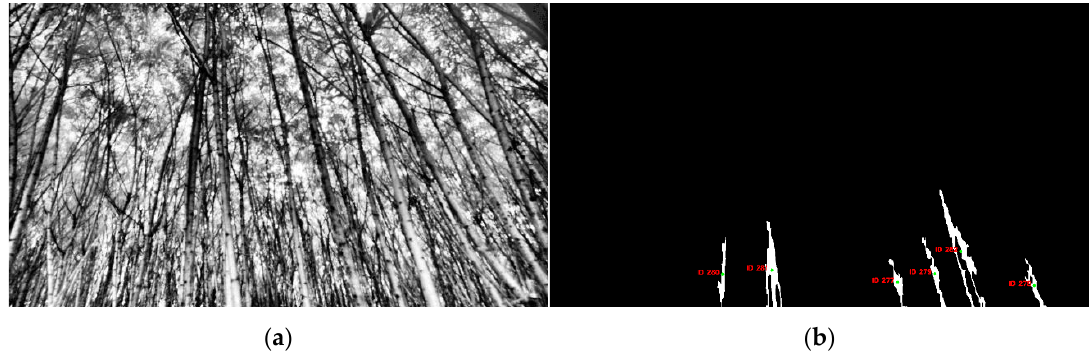
Figure 11. ( a ) CLAHE equalized frame; ( b ) segmentation procedure output with labeled detected trees.